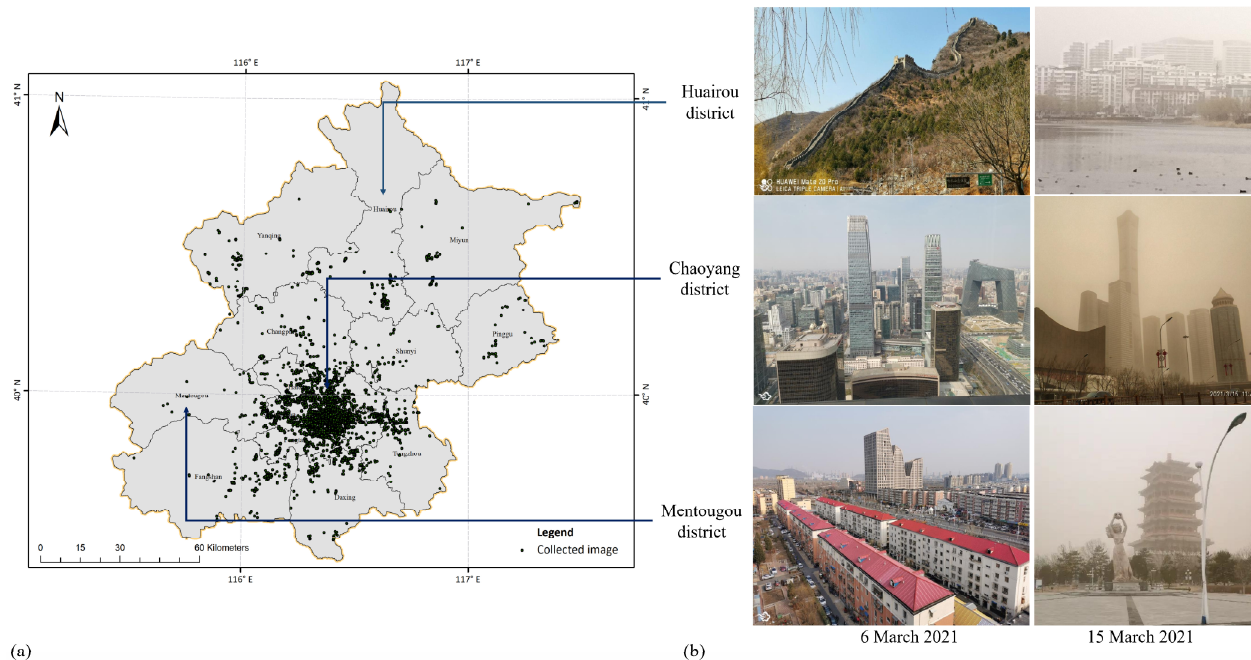
Figure 3. Spatial distribution of photographs crowdsourced from Moji Weather application ( a ) and example photographs taken at three districts ( b ).